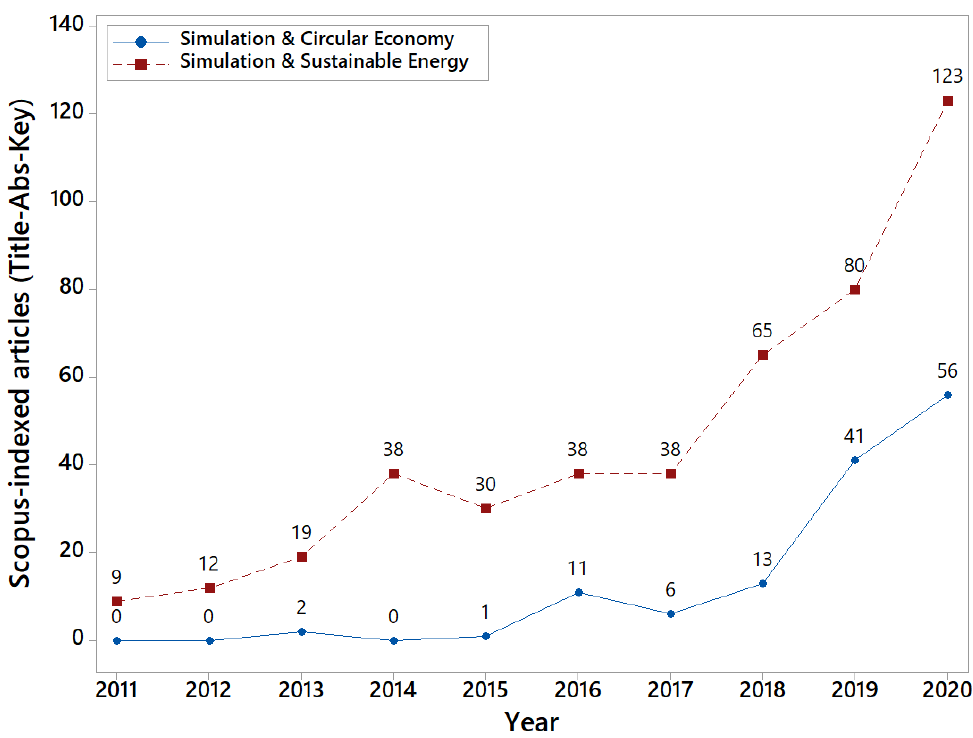
Figure 3. Scopus-indexed articles including “simulation” and (“circular economy” or “sustainable energy”) in